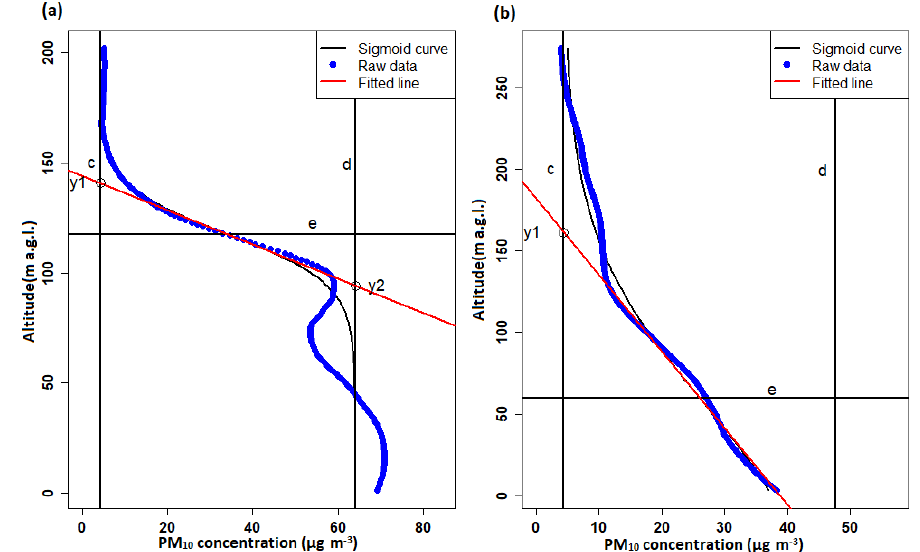
Figure 4. Vertical profiles of the PM 10 concentration with the fitted sigmoid curve and estimated optimal parameters representing the “S”- shaped profile, group III (a) , and significant linear decrease from ground level, group II (b)